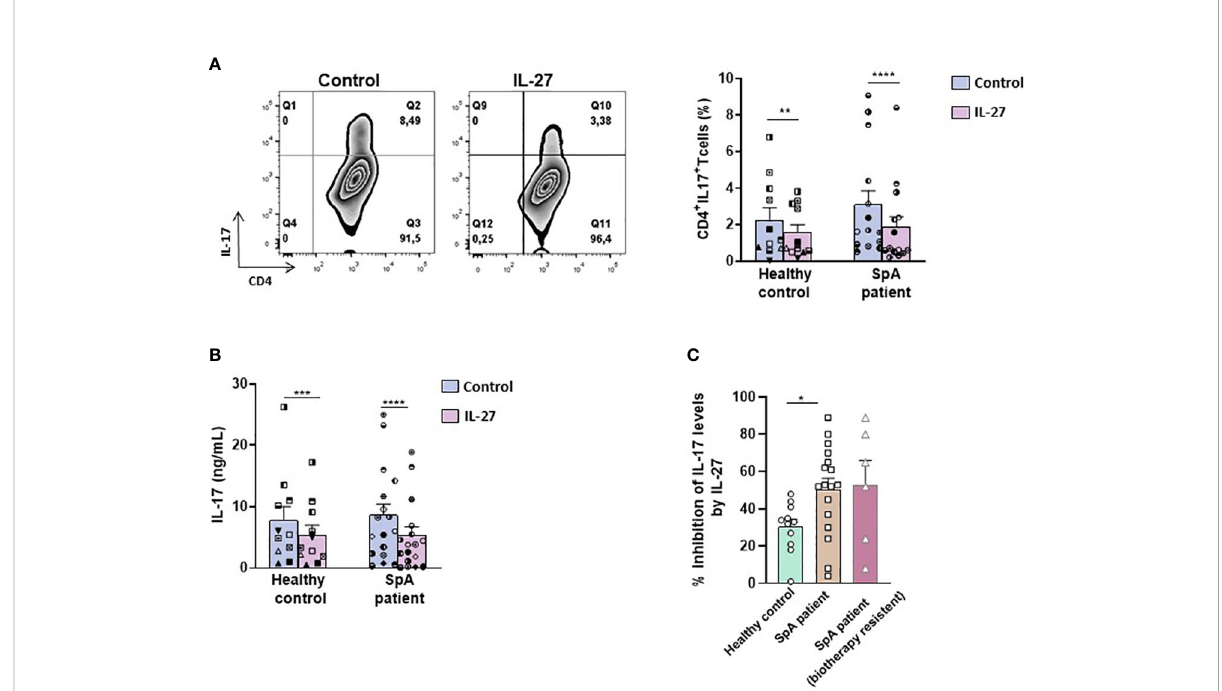
FIGURE 5 IL-27 decreases IL-17 production by T cells from SpA patients. (A) Left panel: representative dot-plot and right panel: percentage of IL-17 producing-CD4 + T cells from SpA patients cultured during 6 days with IL-2 in the presence or absence of IL-27 and determined after PMA/ ionomycin stimulation. (B) IL-17 production was measured in culture supernatants by ELISA. (C) Percentage of inhibition of IL-17 production induced by IL-27 presence in cultures of CD4+T cells from healthy controls and SpA patients. *p < 0.05 **p<0.005 ****p<0.0001/